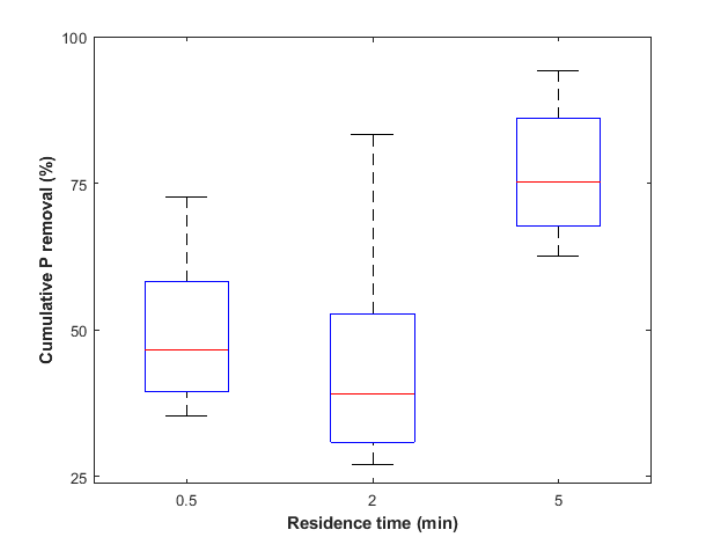
Figure A2. Box plot: effect of residence time (RT) on P removal performance of